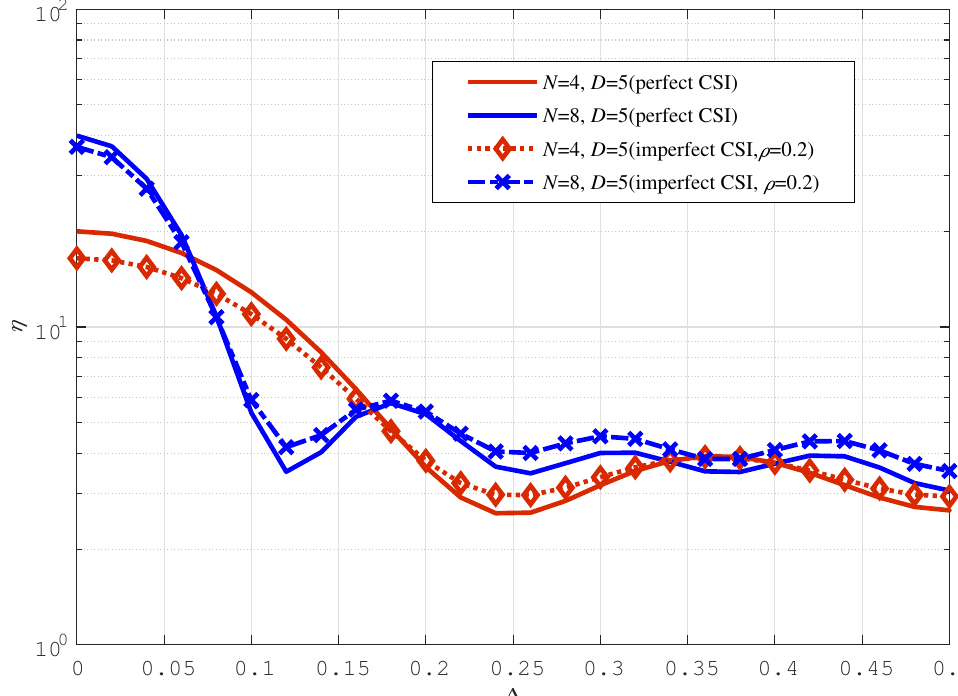
Figure 5. Receiving gain η versus sampling phase offset ∆ over fading